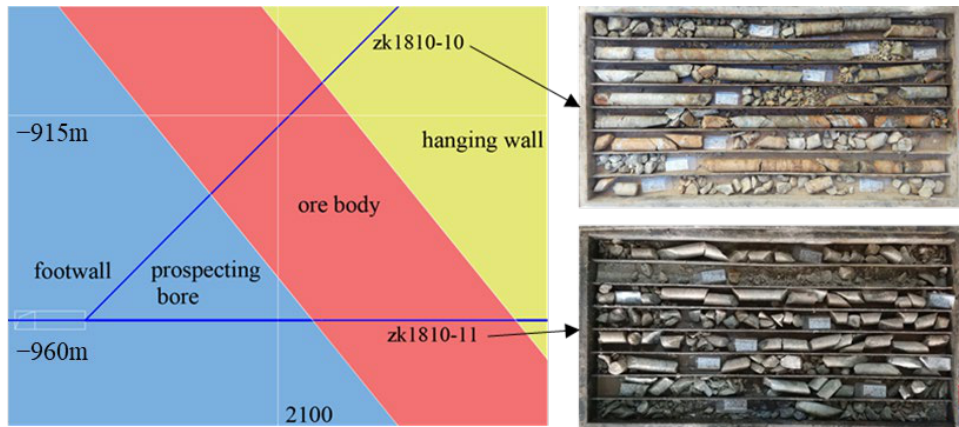
Figure 8. Sublevel open stope and backfilling.